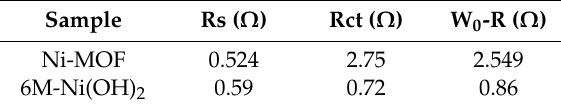
Table 5. Parameters of the equivalent circuit model.